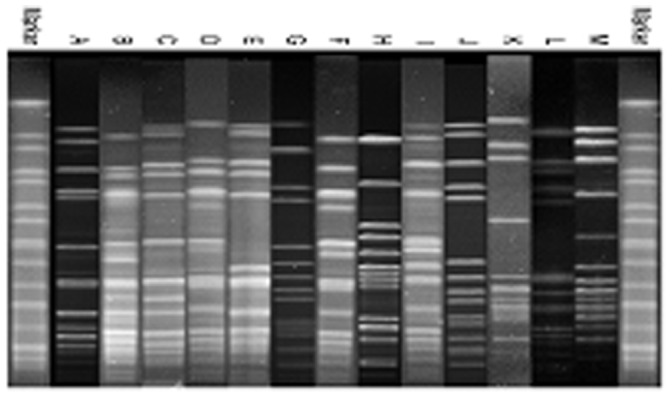
Thirteen representative pulsed-field gel electrophoresis patterns of the 110 CC59 MRSA strains.Lanes marker, chromosomal DNA of Salmonella ser. Braenderup strain H9812 (27) was used as the size marker. (A) SZ12 MRSA ST59-t437-IVa; (B) G20 MRSA ST59-t437-IVa; (C) CQ6 MRSA ST59-t437-IVa; (D) BJ313 MRSA ST59-t437-IVa; (E) SH35 MRSA ST59-t437-V; (F) BJ57 MRSA ST59-t437-IVa; (G) SY183 MRSA ST59-t441-IVa; (H) BJ326 MRSA ST59-t3523-IVa; (I) SZ46 MRSA ST59-t437-IVa; (J) BJ787 MRSA ST59-t437-IVa; (K) SY76 MRSA ST59-t437-V; (L) BJ860 MRSA ST59-t437-V and (M). GZ1 MRSA ST338-t437-V.